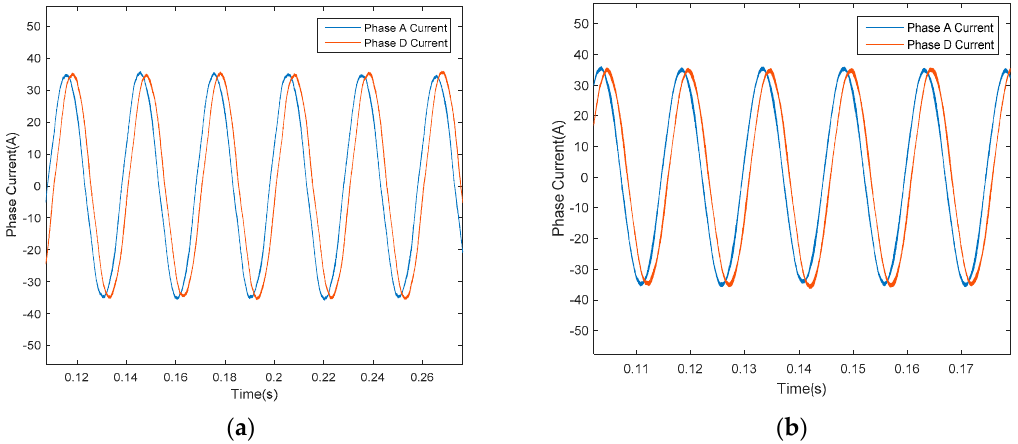
Figure 17. Phase A and D currents after adopting the proposed resonant controller only, ( a ) speed is maintained at 500 rpm, and ( b ) speed is maintained at 1000 rpm.